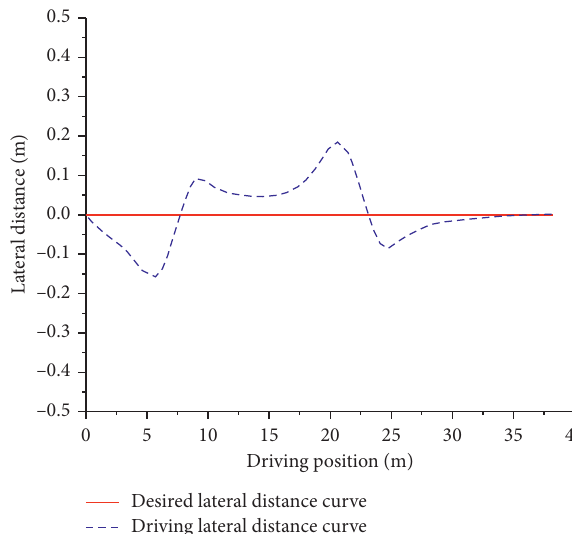
Figure 16: Simulation diagram of lateral position tracking error.